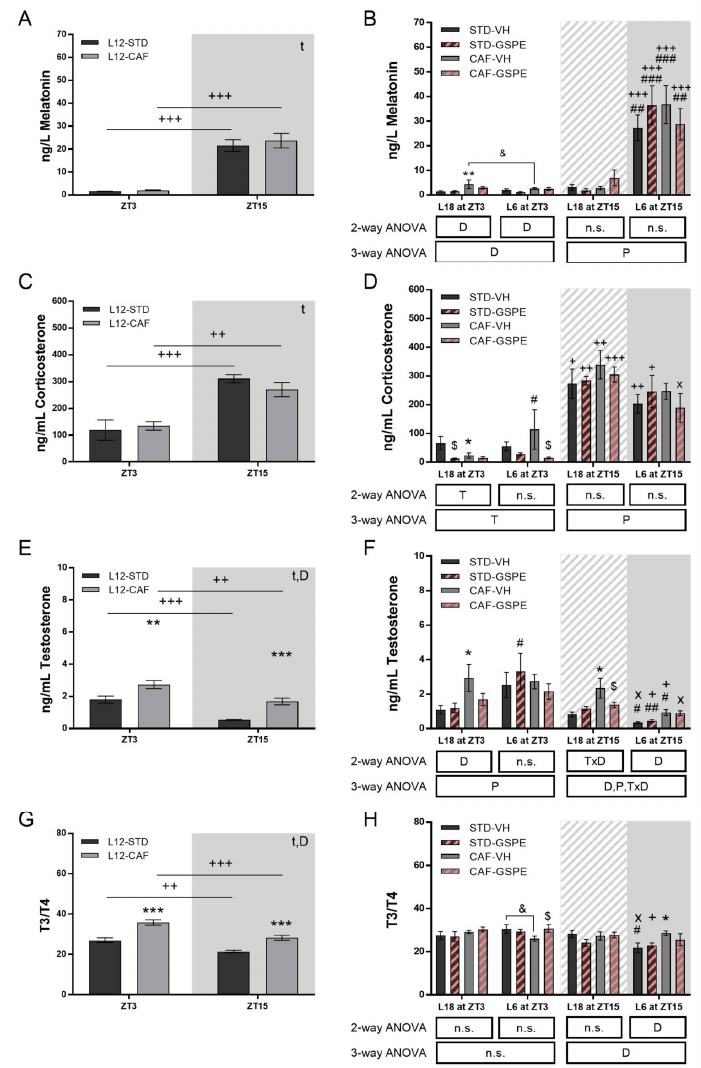
Figure 6. Serum hormones of STD- and CAF-fed rats in the sixth week of the experiment under L12 conditions and in the seventh week of the experiment under L18 and L6 conditions. Serum melatonin at ZT3 and ZT15 ( A ) in L12 and ( B ) L18 and L6 conditions. Serum corticosterone at ZT3 and ZT15 ( C ) in L12 and ( D ) L18 and L6 conditions. Serum testosterone at ZT3 and ZT15 ( E ) in L12 and ( F ) L18 and L6 conditions. Serum T3-to-T4 ratio at ZT3 and ZT15 ( G ) in L12 and ( H ) L18 and L6 conditions. Values are expressed as the mean ± S.E.M. ( n = 6). D, diet effect; T, GSPE treatment effect; P, photoperiod effect; TxD, interaction between treatment and diet; DxP, interaction between diet and photoperiod; n.s., no significant differences. *, ** or *** Indicate significant differences by diet effect ( p ≤ 0.05, p ≤ 0.01 and p ≤ 0.001, respectively), $ Indicate significant differences by treatment effect ( p ≤ 0.05, respectively), #, ## or ### Indicate significant differences by photoperiod effect ( p ≤ 0.05, p ≤ 0.01 and p ≤ 0.001, respectively) using 2-way and 3-way ANOVA followed by a LSD post-hoc test ( p ≤ 0.05). & Indicates tendency using a LSD post-hoc test ( p = 0.1–0.051). +, ++ or +++ Indicate significant differences using a paired Student’s t -test between ZT3 vs. ZT15 for each group ( p ≤ 0.05, p ≤ 0.01 and p ≤ 0.001, respectively). x Indicates tendency using a paired Student’s t -test between ZT3 vs. ZT15 for each group ( p = 0.1–0.051). AUC, Area under curve; GSPE, grape seed proanthocyanidin-rich extract, STD, Standard diet-fed rats; CAF, Cafeteria diet-fed rats; VH, rats administered vehicle; GSPE, rats administered 25 mg/kg GSPE; L12, normal photoperiod 12 h light per day; L18, long photoperiod 18 h light per day; L6, short photoperiod 6 h light per day. Grey background, dark phase. slash background, transitions